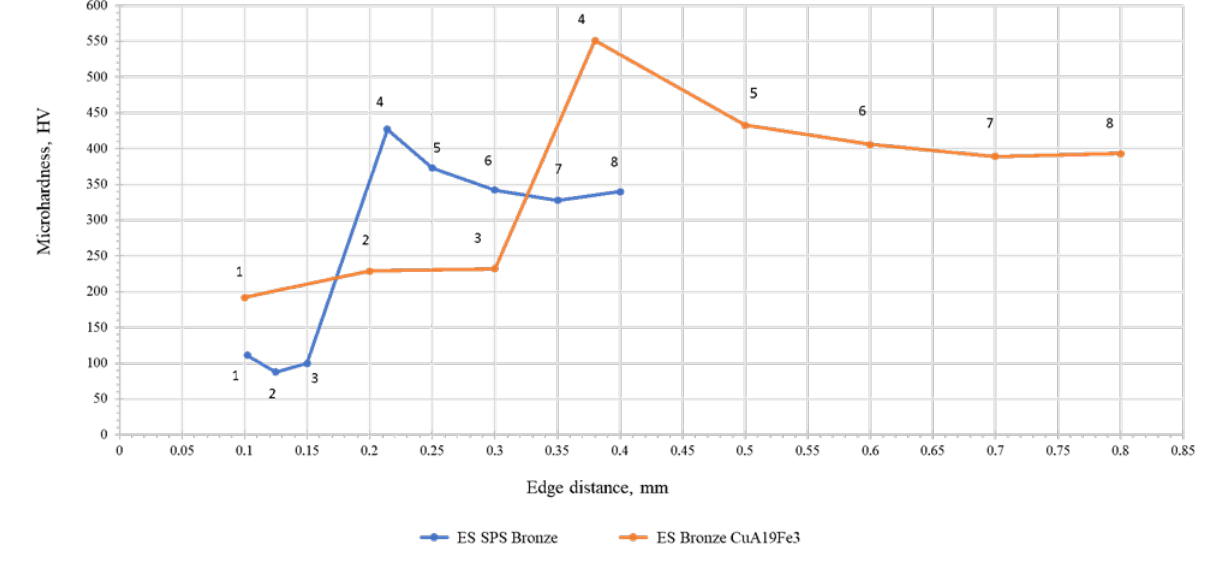
Figure 6. Distribution of microhardness by depth of coatings composed of CuAl9Fe3 bronze and SPS bronze. 1–3: coating; 4: thermal exposure zone; 5–8: base material.